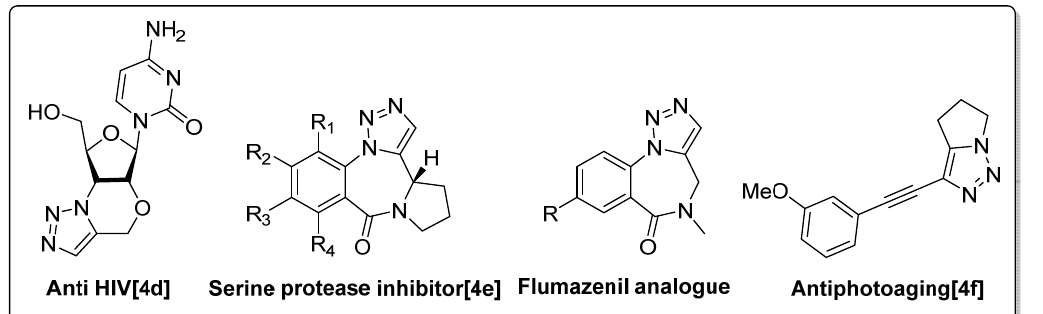
Figure 1. Bioactive moieties containing a fused 1,2,3-triazole motif.